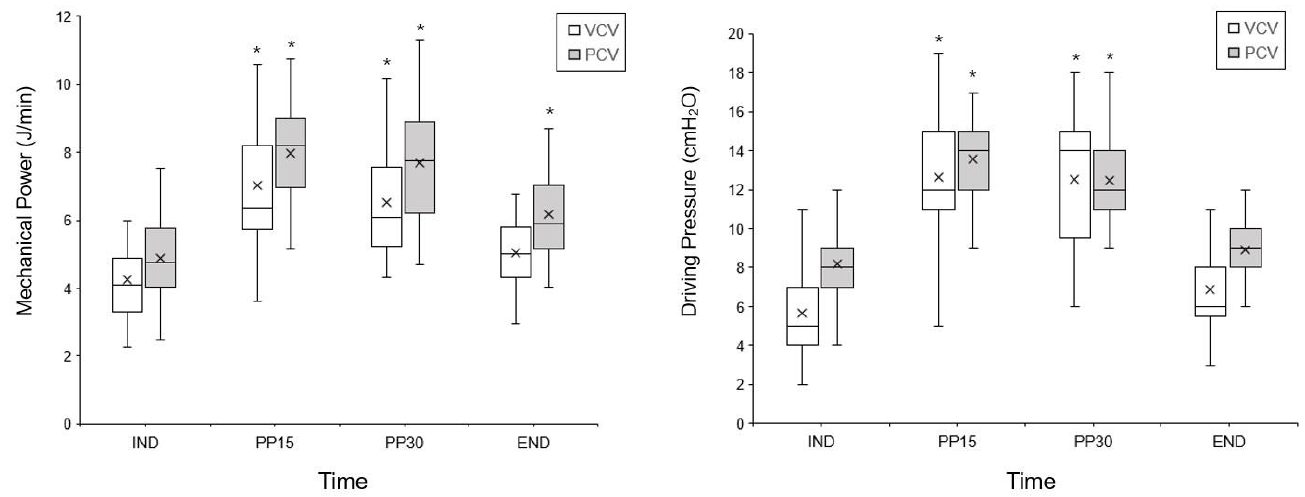
Figure 2. The change in mechanical power (MP) and driving pressure (DP) during the surgery. VCV, volume-controlled ventilation; PCV, pressure-controlled ventilation-volume guarantee; IND, 10 min after anesthesia induction; PP15 and PP30, 15 and 30 min after pneumoperitoneum induction; END, the end of surgery. There was no significant difference in the change over time in the MP ( p = 0.911), whereas the change over time in the DP was significantly different between the groups ( p = 0.001). Error bars, boxes, middle lines, and x represent the range (minimum-maximum), interquartile range, median, and mean, respectively. * p < 0.05, vs. IND within the group.